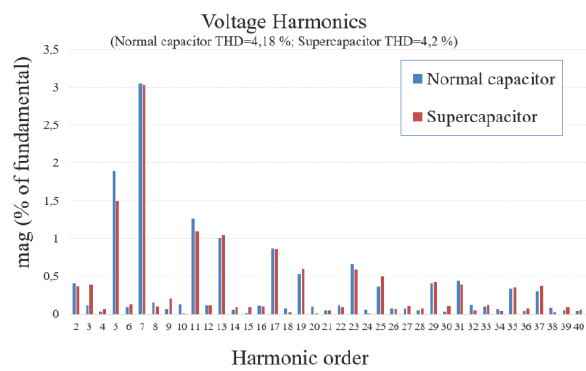
Figure 12. Input voltage